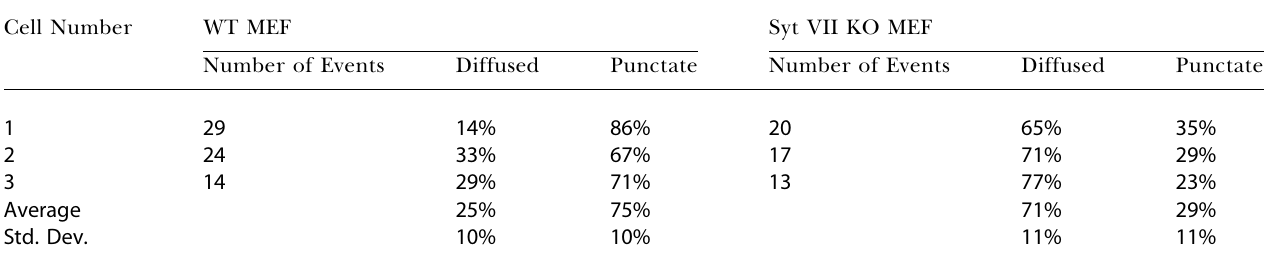
Figure 2. Fate of Membrane Protein during Lysosomal Fusion Lysosomal membranes in MEFs were labeled by transfecting cells with a vector encoding a CD63–GFP fusion protein, and expression was allowed for 48 h. For simultaneous labeling of lysosomal mem- brane and lumen, the CD63–GFP trans- fected cells were labeled with 70 kDa TRITC–dextran as described in Figure 1. (A) Following ionophore-induced calci- um increase in WT MEFs, when the TRITC–dextran was released completely (left), CD63–GFP (right) was delivered to the plasma membrane, but it remained in multiple puncta near the site of fusion rather than diffuse away. The panels are pseudocolor surface plots, with the x and y axis representing the coordinates and the z axis representing the fluorescence intensity of individual pixels. (B) In the event of partial release of TRITC–dextran (top row), the CD63– GFP (bottom row) did not appear to be delivered to the plasma membrane. The lower panel shows the plot of fluorescent intensity of lumenal and membrane label (within the dotted circle) of the lysosome shown in (B). (C and D) Analysis of CD63–GFP-labeled lysosomes in WT MEFs (C) and in Syt VII KO MEFs (D) indicates that while CD63– GFP is retained in puncta in the WT MEFs, it diffuses freely in the plasma membrane in the SytVII KO MEFs. The lower panel shows the total and peak intensity plots of CD63–GFP-labeled lysosome in